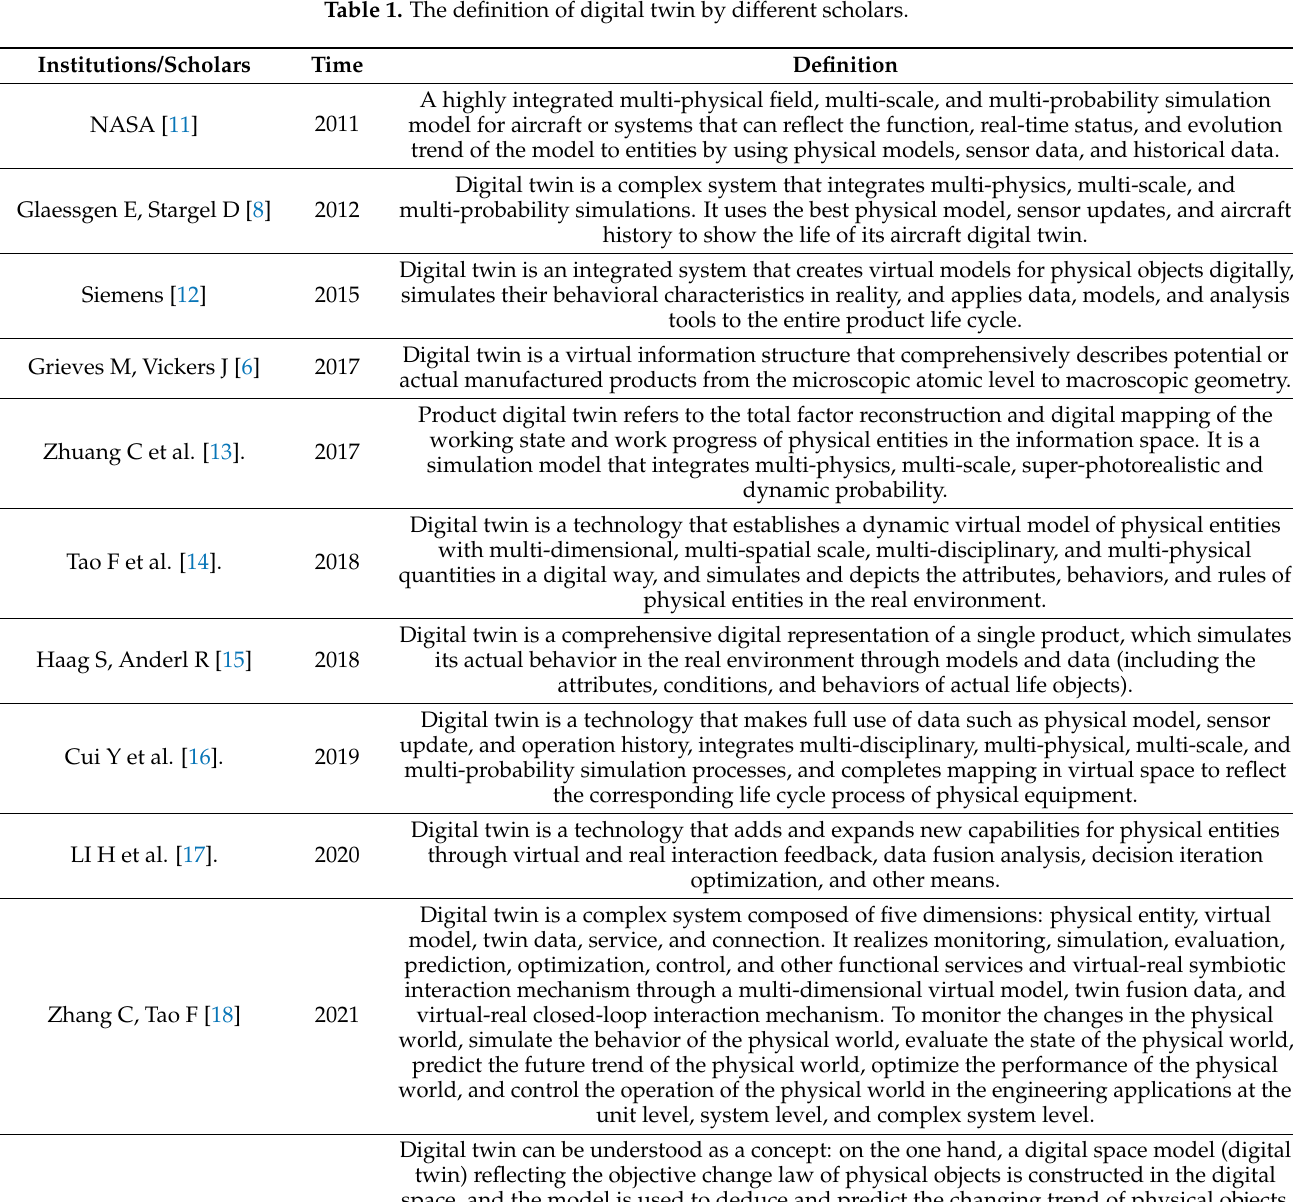
Table 1. The definition of digital twin by different